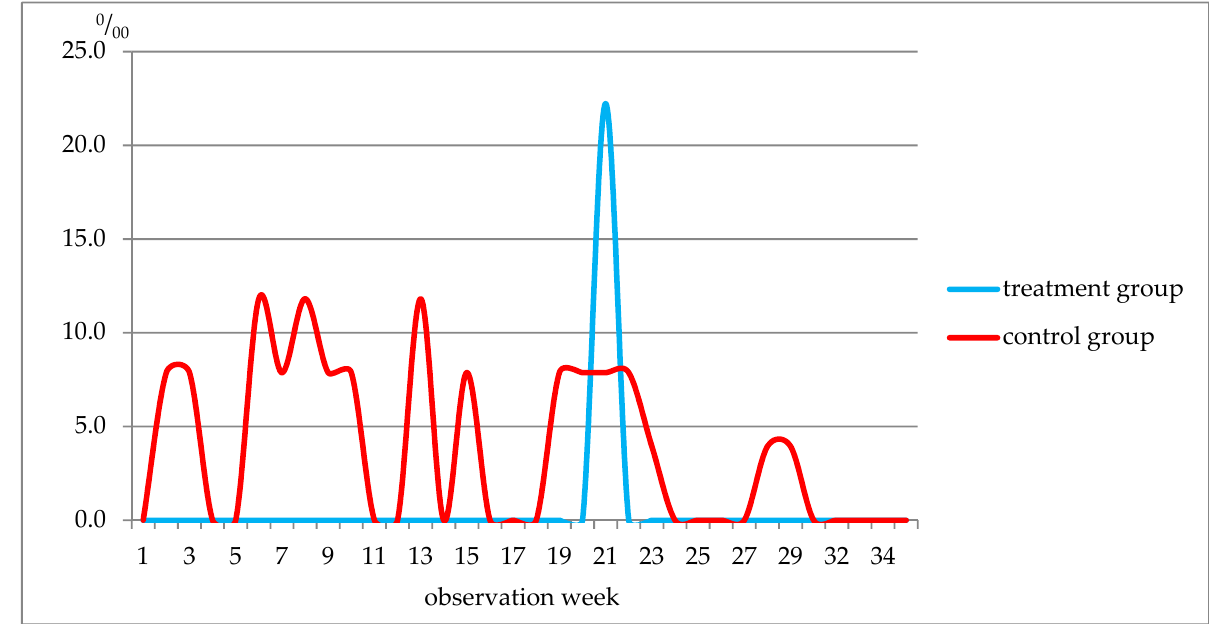
Figure 3. The incidence rate of diseases of the skin and subcutaneous tissue in the control group by observation weeks, ‰.